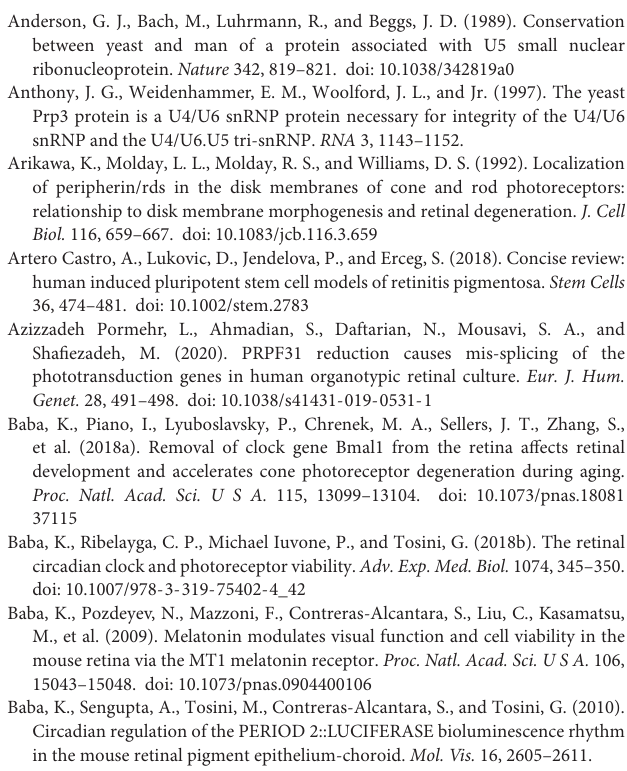
Supplementary Table 1 | PRPFs implicated in RP. Supplementary Table 2 | Mis-spliced genes affected by PRPF31 mutations. Supplementary Table 3 | Pros and cons of different disease